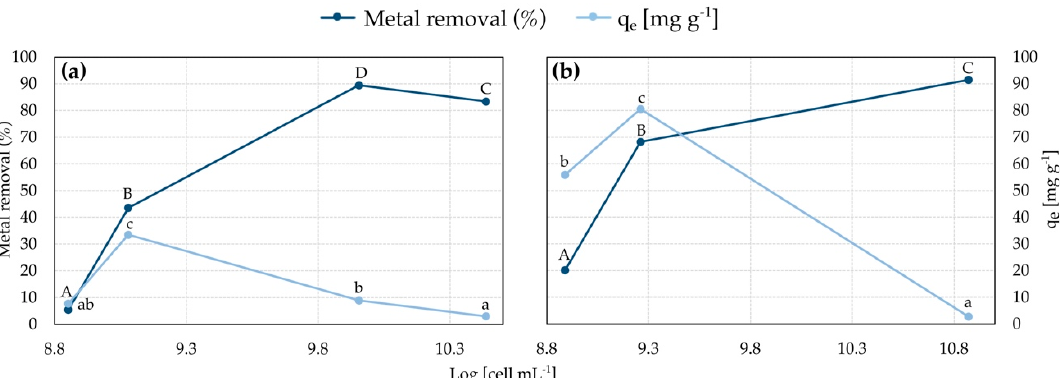
Figure 8. Effect of biomass dose on biosorption capacity and removal of Ni 2+ ( a ) by S. plymuthica strain SC3I(2) and Cu 2+ ( b ) by S. plymuthica strain As3-5a(5) (initial Ni 2+ concentration, 50 mg L − 1 ; initial Cu 2+ concentration, 200 mg L − 1 ; temperature, 24 ◦ C; agitation rate, 100 rpm; contact time, 30 min). Letters indicate whether the values differ significantly according to Tukey’s test ( p <